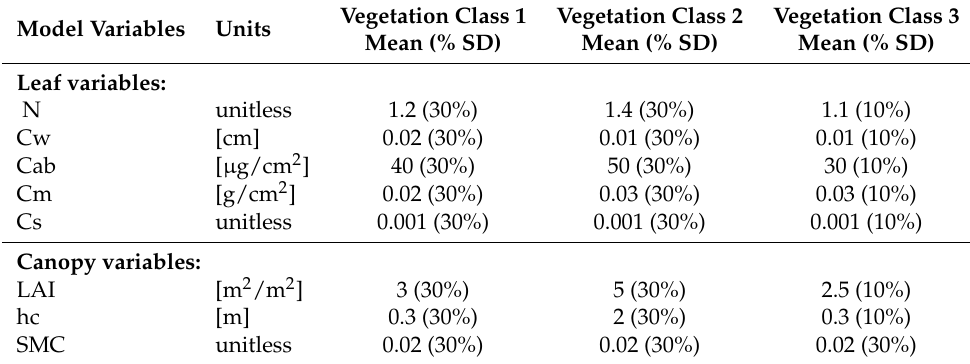
Table 2. Range of vegetation input variables used to fill the three synthetic land cover